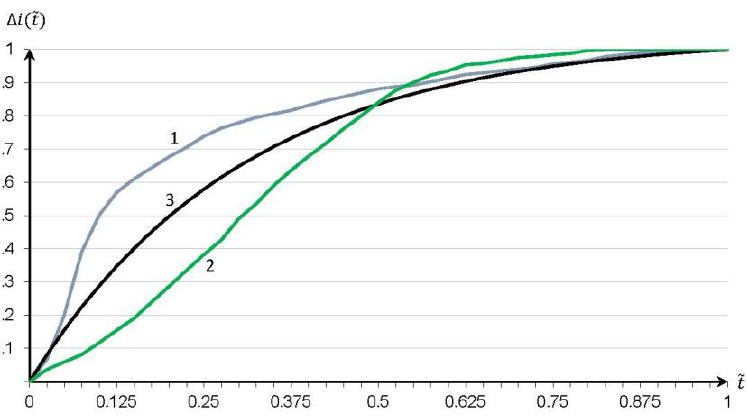
Figure 2. Comparison of enthalpy graphs ∆ i ( (cid:101) t ) at dimensionless time (cid:101) t ∈ [ 0,1 ] (blue line is graph 1, green line is graph 2, black line is graph 3).